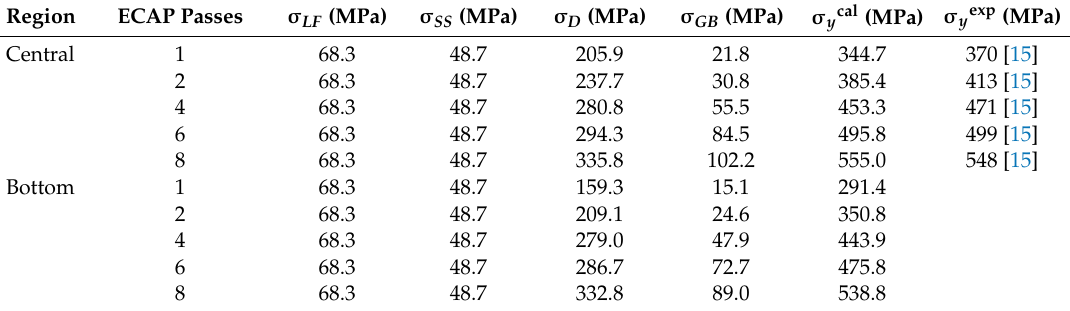
Figure 7. Calculated and experimental [15] yield strengths in the central and bottom regions of the ECAPed Cu-Mg alloy. Table 1. The strength contributions from various strengthening mechanisms and the calculated and experimental yield